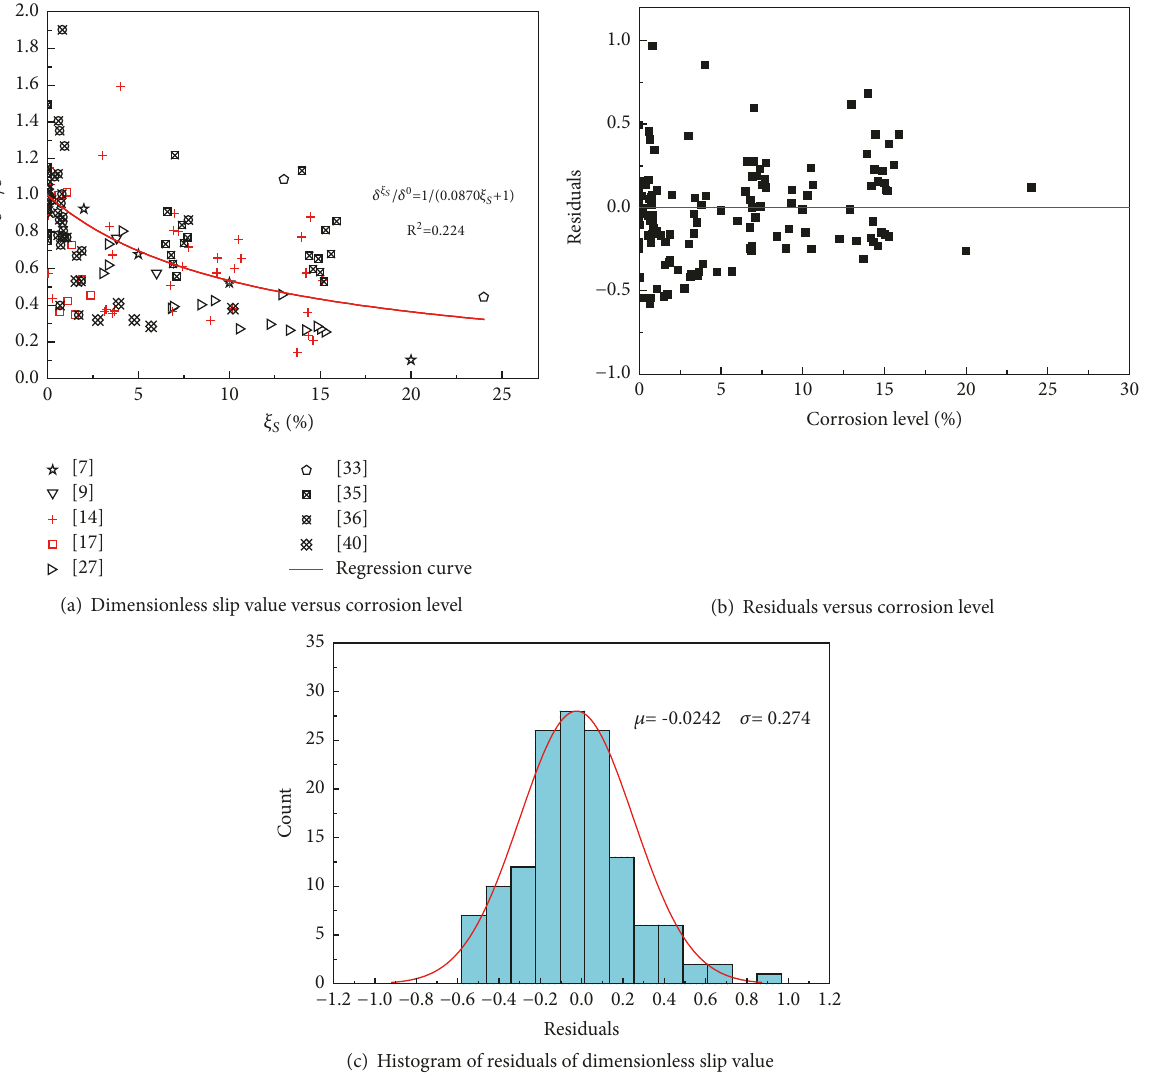
Figure 6: Dimensionless slip value corresponding to bond strength of pull-out specimens with deformed rebar (stirrups): (a) dimensionless slip value versus corrosion level; (b) residuals versus corrosion level; (c) histogram of residuals of dimensionless slip value.